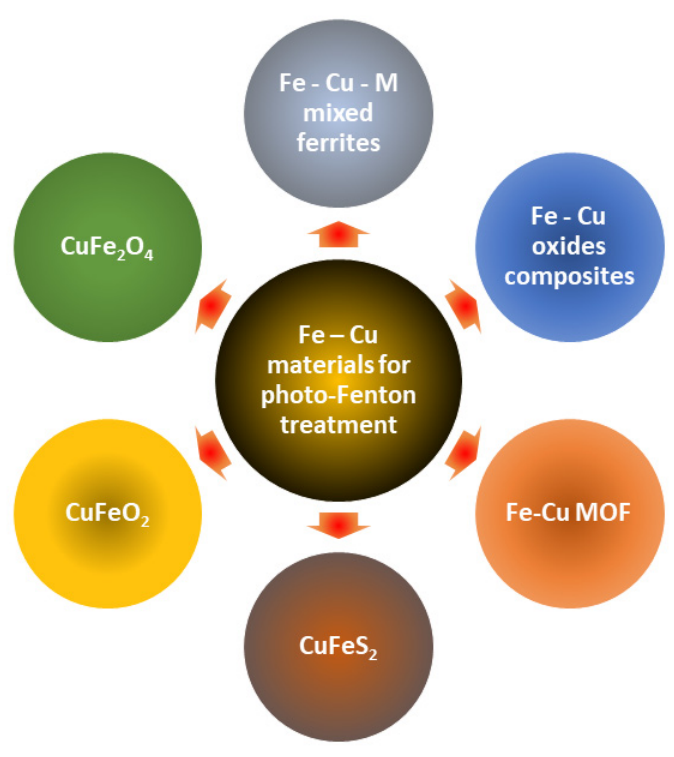
Figure 1. Classification of the different Fe–Cu based materials applied as catalysts in photo–Fenton processes.